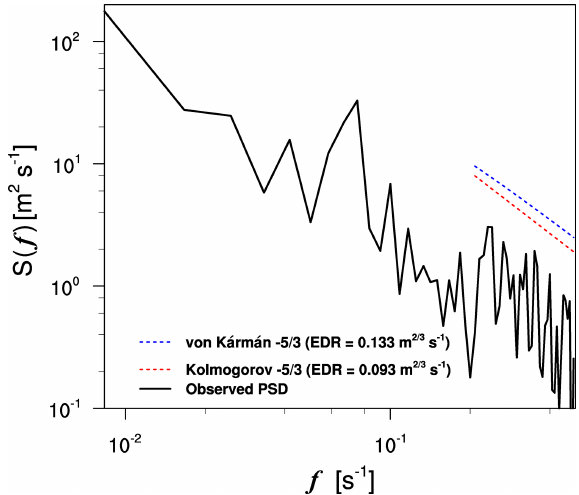
Figure 6. The energy spectrum of the zonal wind component ob- tained from the QAR data at 10:38UTC on 11 October 2012. The dashed line represents the theoretical von Kármán (blue) and Kol- mogorov (red) inertial range slope f − 5 / 3 in the frequency